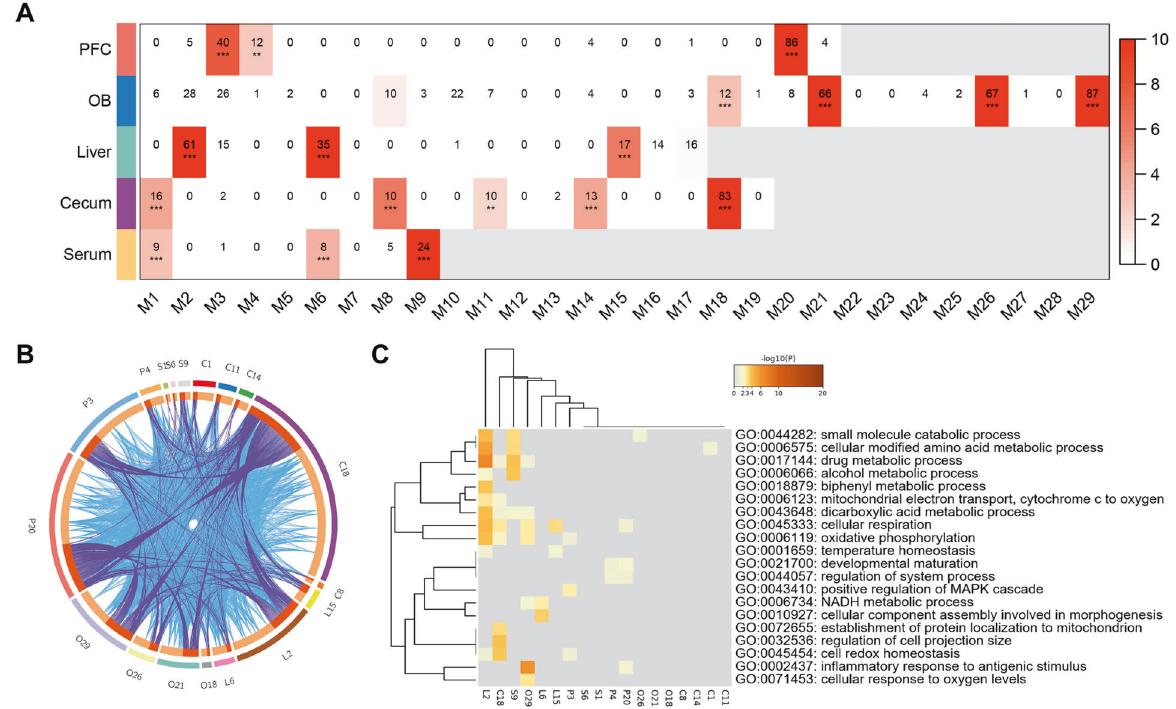
Fig. 3 DE proteins and microbiota-related coexpression modules. A Matrix summarizes enrichment of DE proteins in coexpression modules for each tissue. The signi fi cance of enrichment ( − log10 (BH-corrected p value), one-sided Fisher ’ s exact test) is scaled by color intensity. BH- corrected ** p < 0.01, *** p < 0.001. B Circos plot shows overlapped proteins in modules from PFC, OB, liver, cecum, and serum. The outside arcs of circus plot represent each module, and the inside arcs represent the proteins in each module. Dark orange represents the proteins that appear in multiple module and light orange represents proteins that are unique to that module. Purple links indicate the overlapped proteins among modules, and blue links indicate the functional overlap among modules. C GO enrichment analysis for 18 microbiota-related modules. The heatmap cells are colored by the p values of representative GO